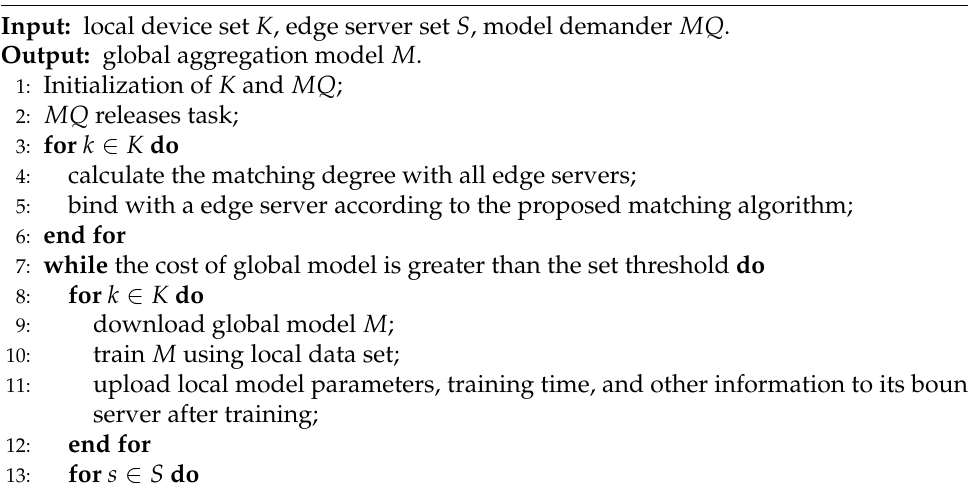
Algorithm 2 BD-FL training.